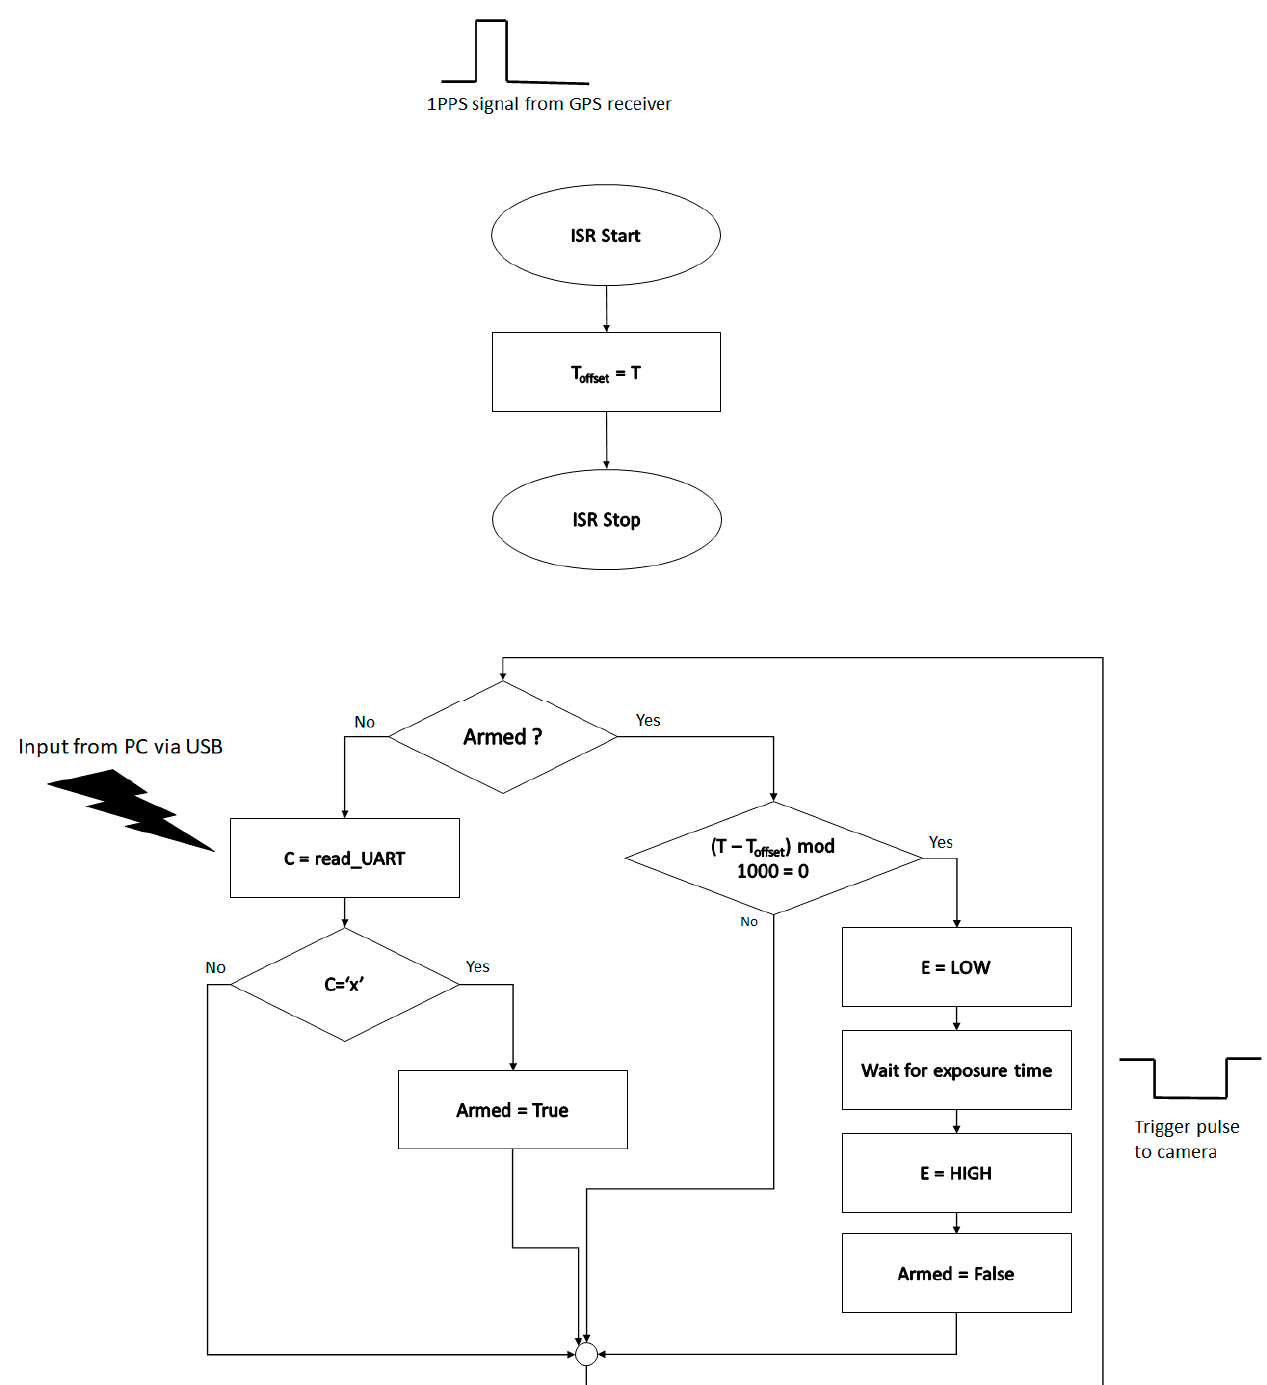
Figure 3. The triggering algorithm of the synchronization interface.